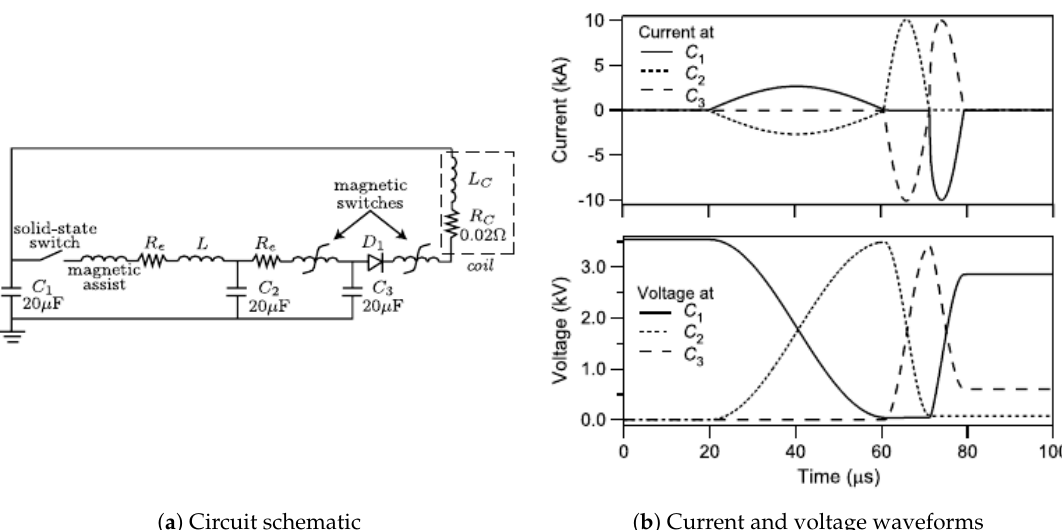
Figure 25. Pulse compression ring ( a ) circuit schematic and ( b ) current and voltage waveforms at each of the three capacitors (Reproduced/modified from [89]; with the permission of AIP Publishing).